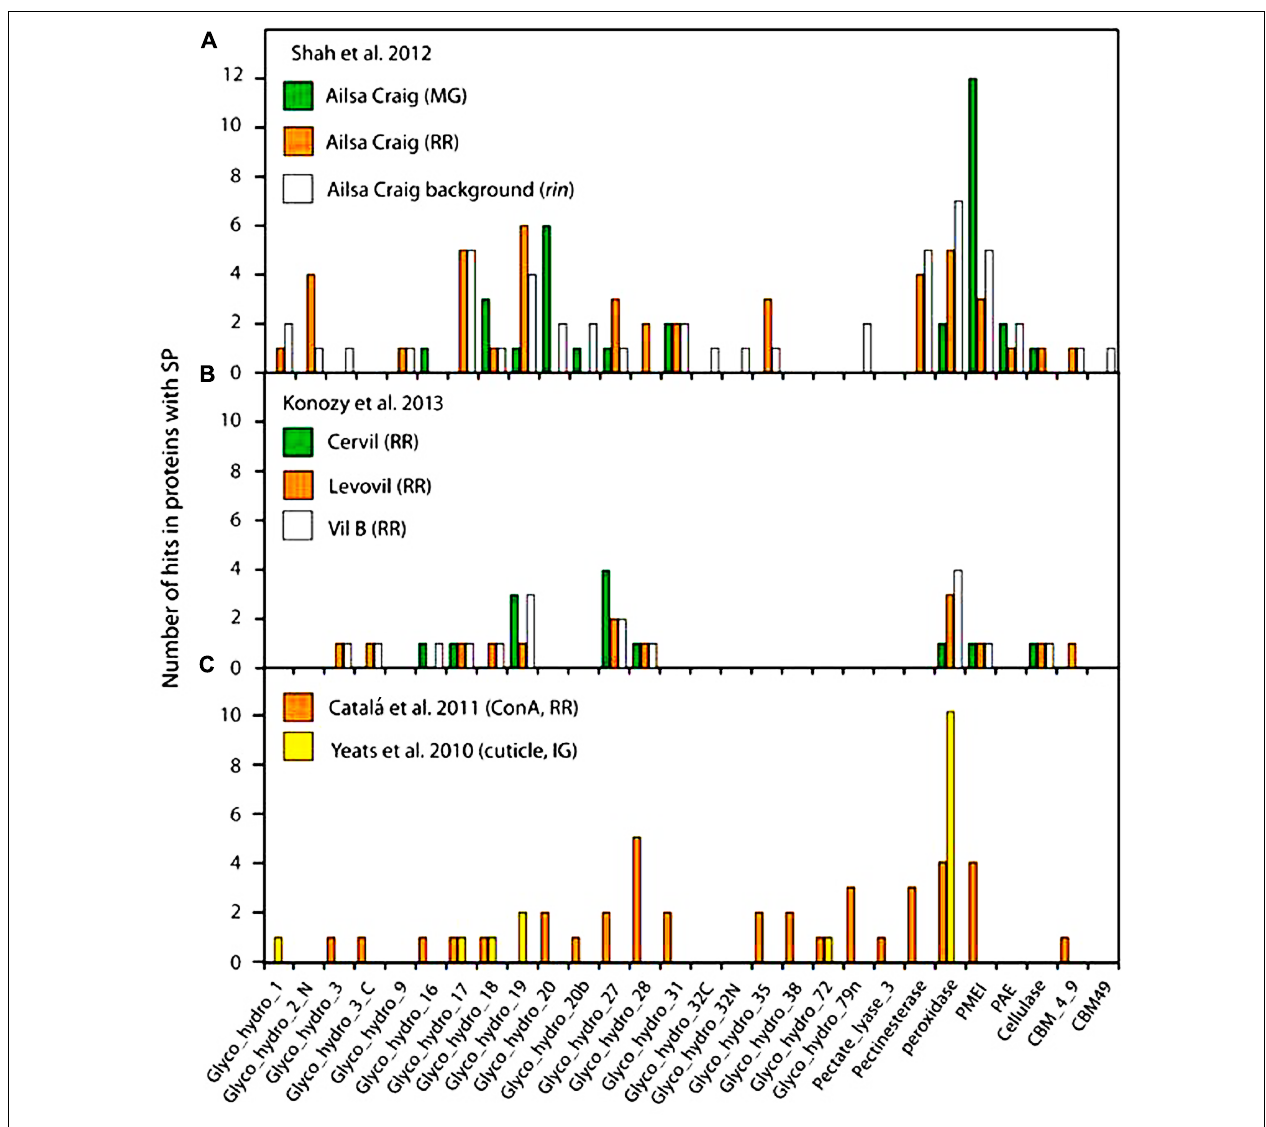
FIGURE 2 | Classification of tomato fruit proteins with a SP described in the cited publications, generated using the Pfam database (http://pfam. sanger.ac.uk). (A) Classification of proteins identified in MG stage, RR stage, and rin mutant and of tomato fruit infected with B. cinerea . (B) Classification